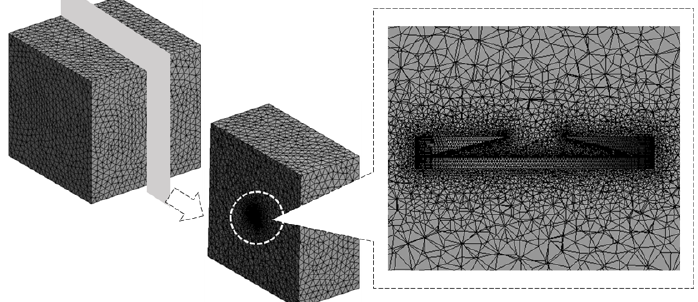
Figure 8. Section view of meshed body